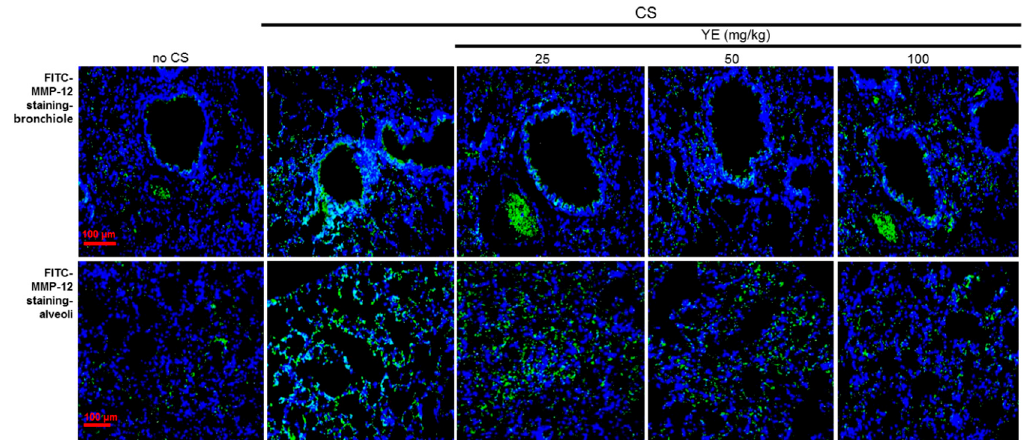
Figure 3. Inhibition of alveolar emphysema by dried yeast extracts (YE) in cigarette smoke (CS)-challenged mouse alveoli. Immunohistofluorescence analysis was done in tissues of small airways and alveoli of CS-challenged mice. The MMP-12 localization was identified as FITC-green staining in mouse airways exposed to CS. Nuclear staining was done with DAPI (blue). Each photograph is representative of four mice. Scale bars = 100 µm.